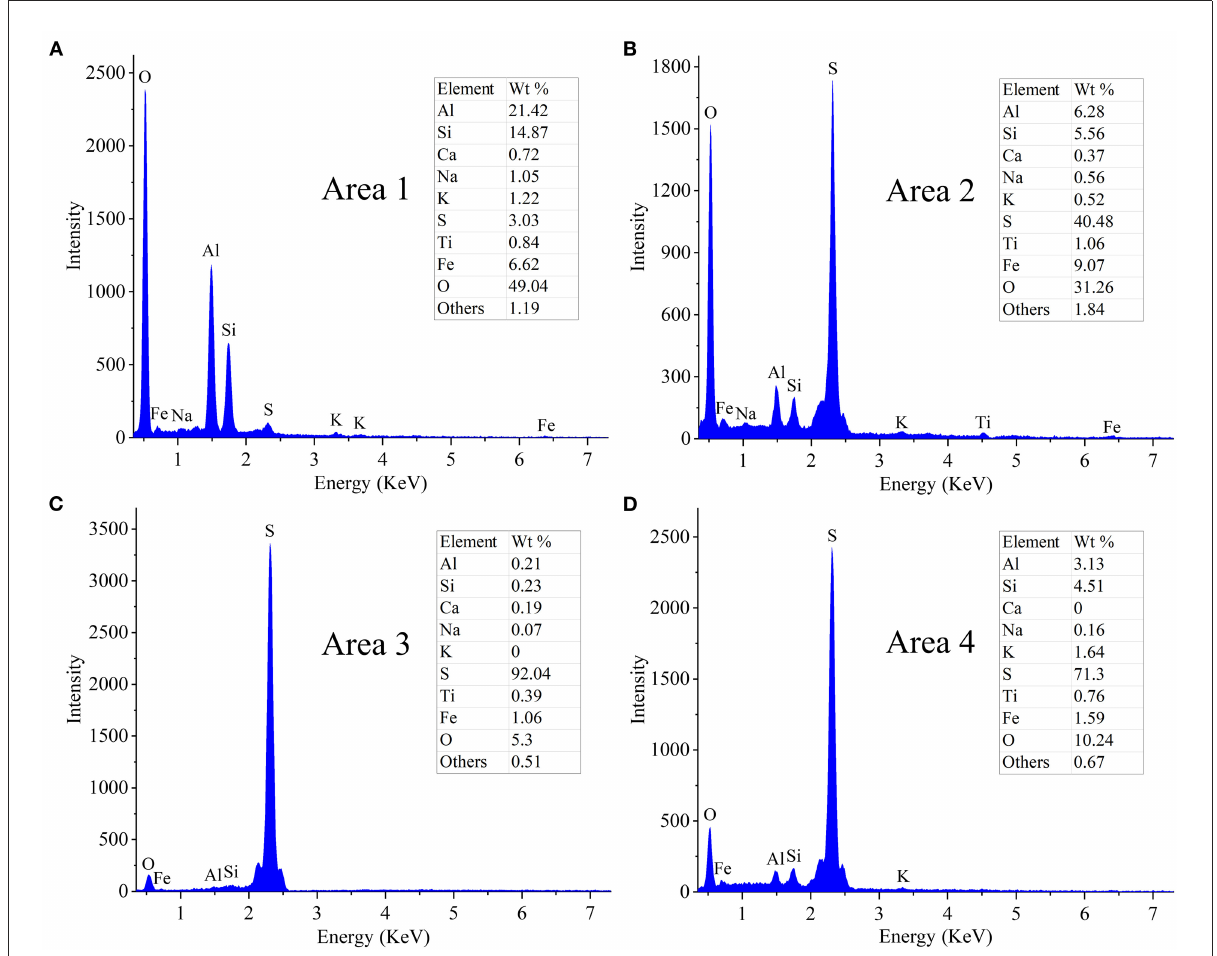
FIGURE4 EDS spectra of solid residues after bioleaching of metals from RM. Bioleaching was conducted for 27 days in shake flasks with the S 0 /RM mass ratio of (A) 0:1, (B) 1:1, (C) 2:1, and (D) 3:1. EDS spectra in (A–D) correspond to Areas 1, 2, 3, and 4 marked in Figure 3 by white rectangles,